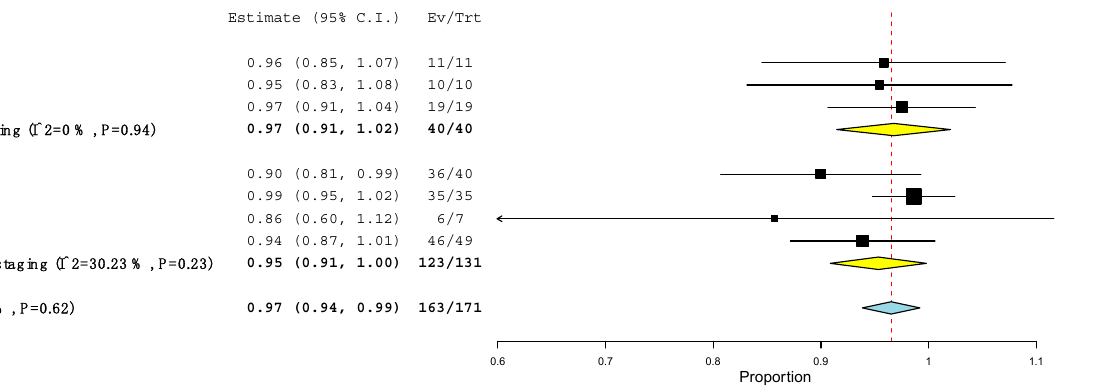
Figure 2. Sensitivity of 18 F-FDG PET/CT at the level of patients across studies.